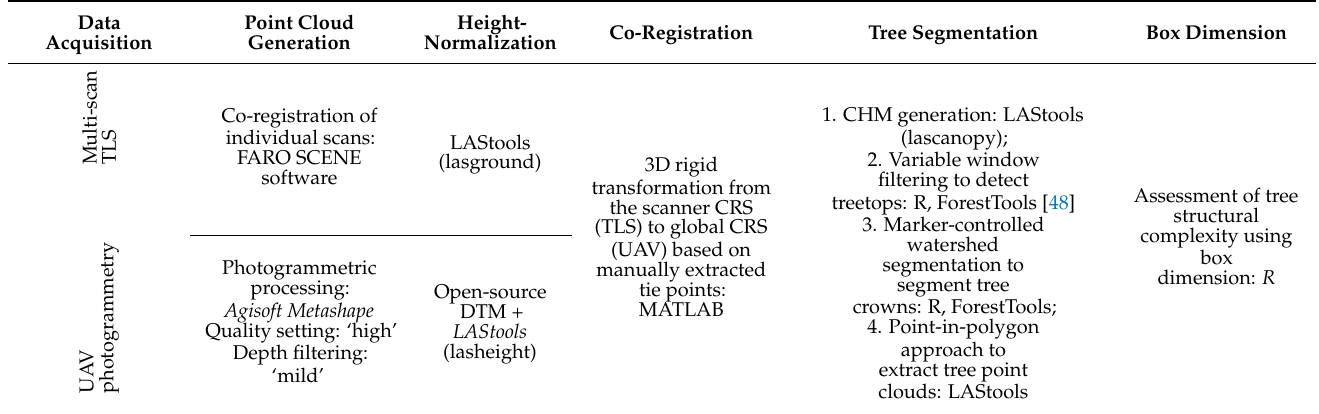
Table 4. Workflow of terrestrial laser scanning (TLS) and unmanned aerial vehicle (UAV) measured point cloud data processing. DTM = digital terrain model, CRS = coordinate reference systems, CHM = canopy height model, R = statistical software